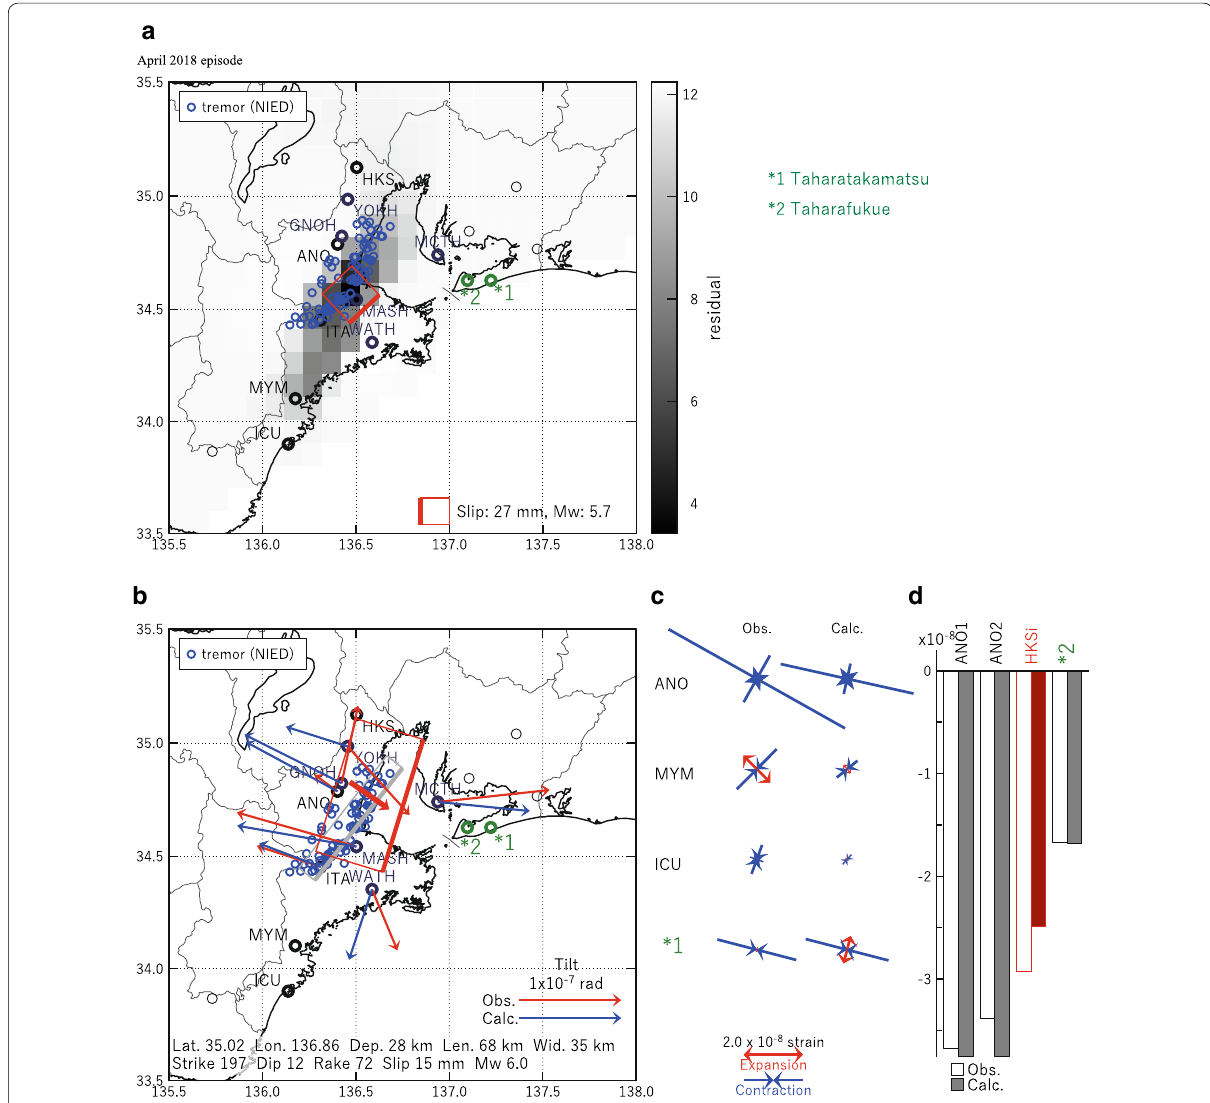
Fig. 10 Estimated fault model of the short-term SSE in April 2018. See caption of Fig. 6. The gray rectangle in b is the fault model estimated by excluding HKSi